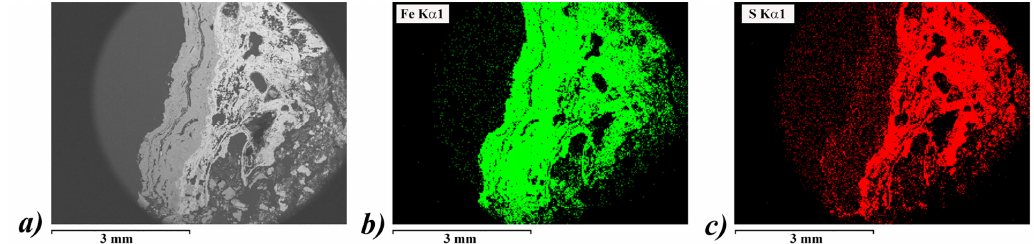
Figure 8. SEM images ( a ) of a representative polished section of a core around a nail together with the EDX mapping of the acid precursors iron (green, ( b )) and sulfur (red, ( c )). The EDX mapping is attributed to the signal of K α emission.